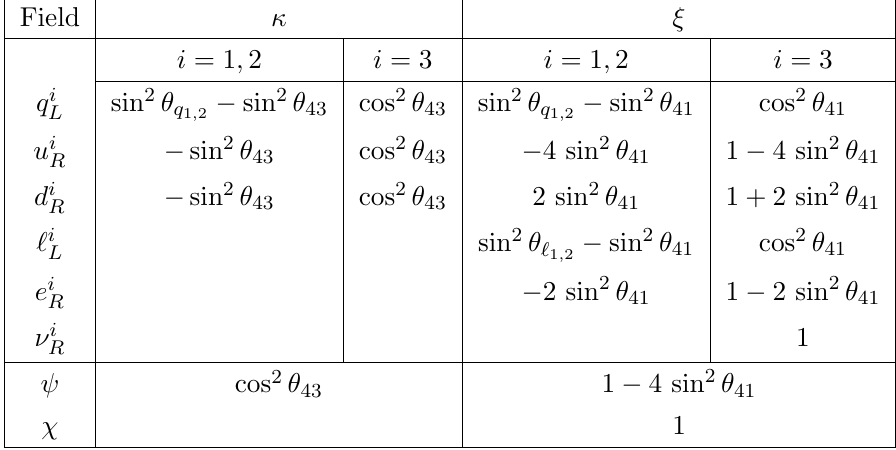
Table 2 . Constants (cid:20) and (cid:24) entering the couplings of fermions to G 0 and Z 0 (cf. eq. (2.14)).